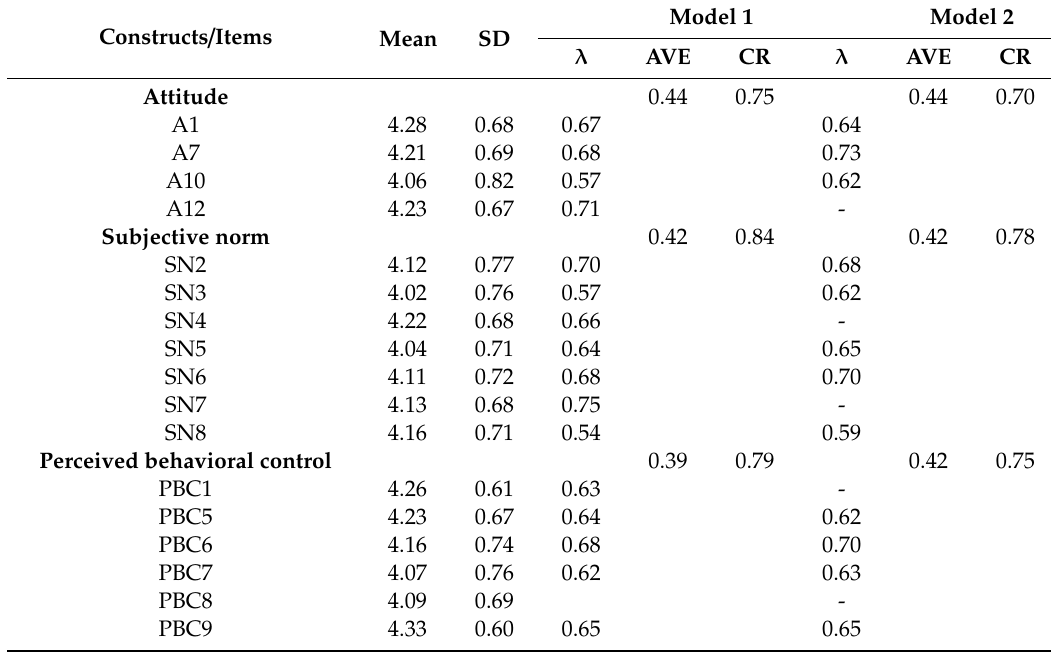
Table 4. Standardised Factor Loading of Confirmatory Factor Analysis for the CFA Sample ( n =